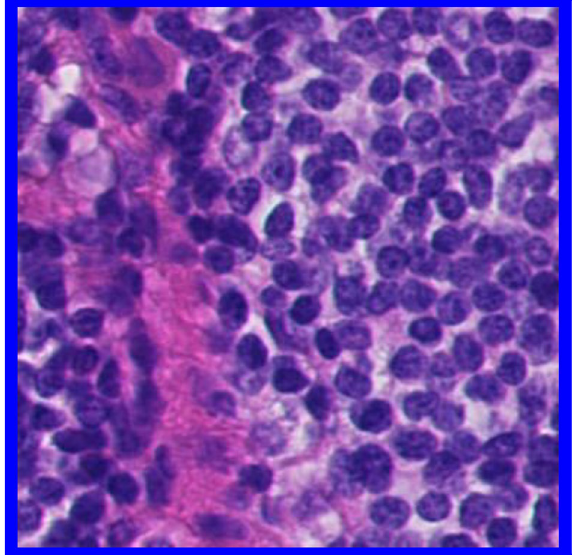
Figure 8. Sample non-tumorous patch at 20 × magnification from Hospital 3.